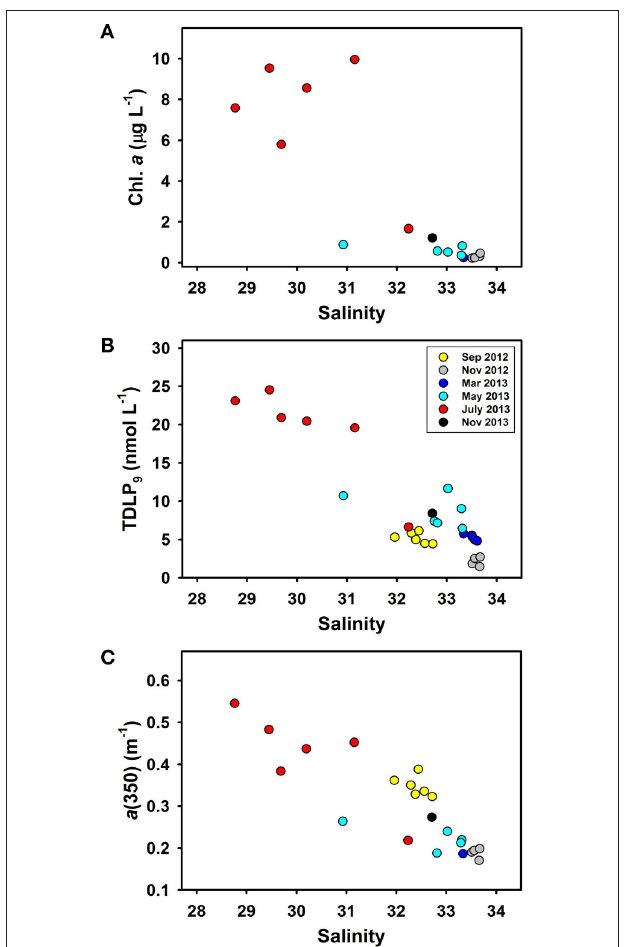
FIGURE 2 | Relationships between salinity and (A) chlorophyll a (Chl. a ), (B) dissolved lignin phenol concentrations (TDLP 9 ), and (C) CDOM absorption coefficients [ a (350)] in surface waters of Otsuchi